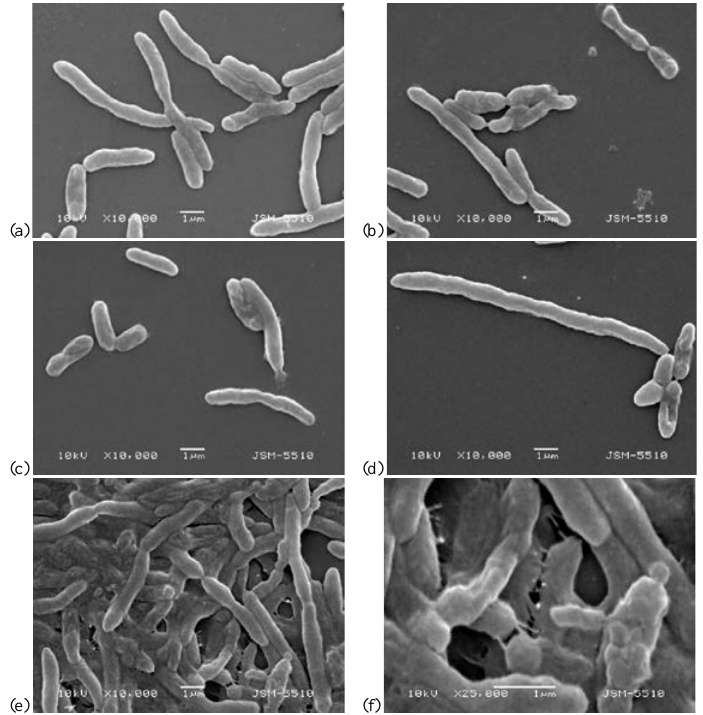
Figure 11. SEM analysis of cells of E. coli NBIMCC 8785 influenced with 10% peptide fraction (MW < 10 kDa): ( a ) control—18 h bacterial culture at 10,000× magnification; ( b – f ) damaged bacterial cells of E. coli NBIMCC 8785 after action of the peptide fraction for 6 h.